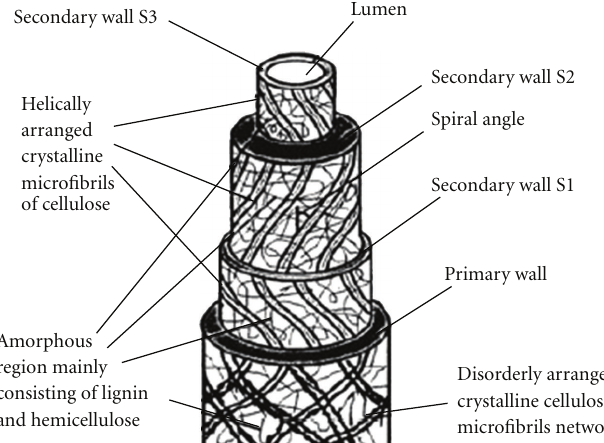
Figure 1: Structural constitution of natural fiber cell